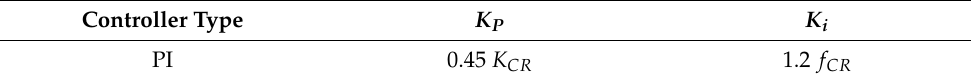
Figure 6. The closed-loop control block diagram of the proposed CSI. Figure 5. The closed-loop control diagram of the proposed CSI. Table 2. Ziegler–Nichols control parameters for P and I gains.